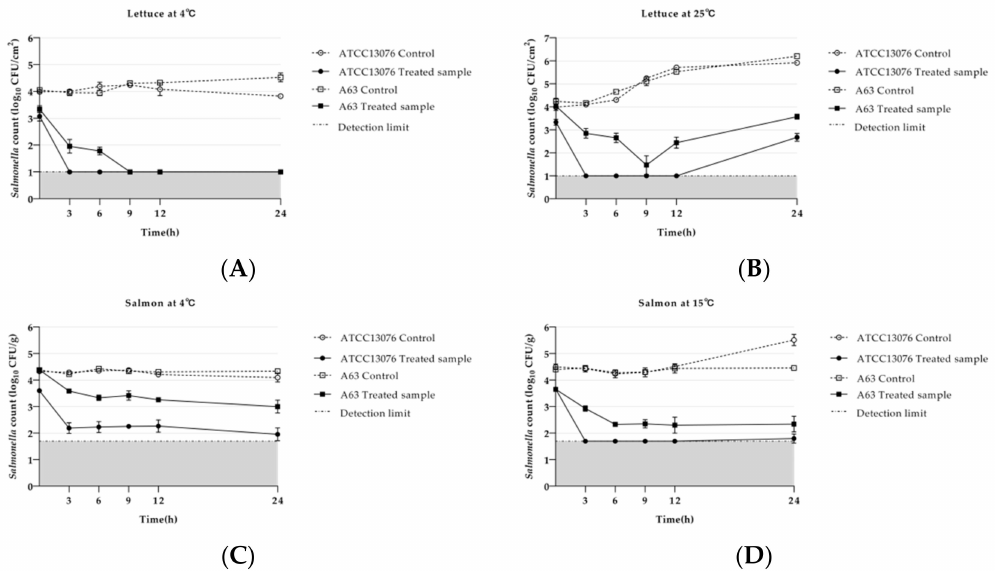
Figure 7. Effect of phage SPJ41 on reducing Salmonella in lettuce. ( A , B ) Effect of phage SPJ41 on reducing S . Enteritidis ATCC13076 and MDR S . Derby A63 on lettuce at 4 ◦ C and 25 ◦ C. ( C , D ) Effect of phage SPJ41 on reducing S . Enteritidis ATCC13076 and MDR S . Derby A63 in salmon at 4 ◦ C and 15 ◦